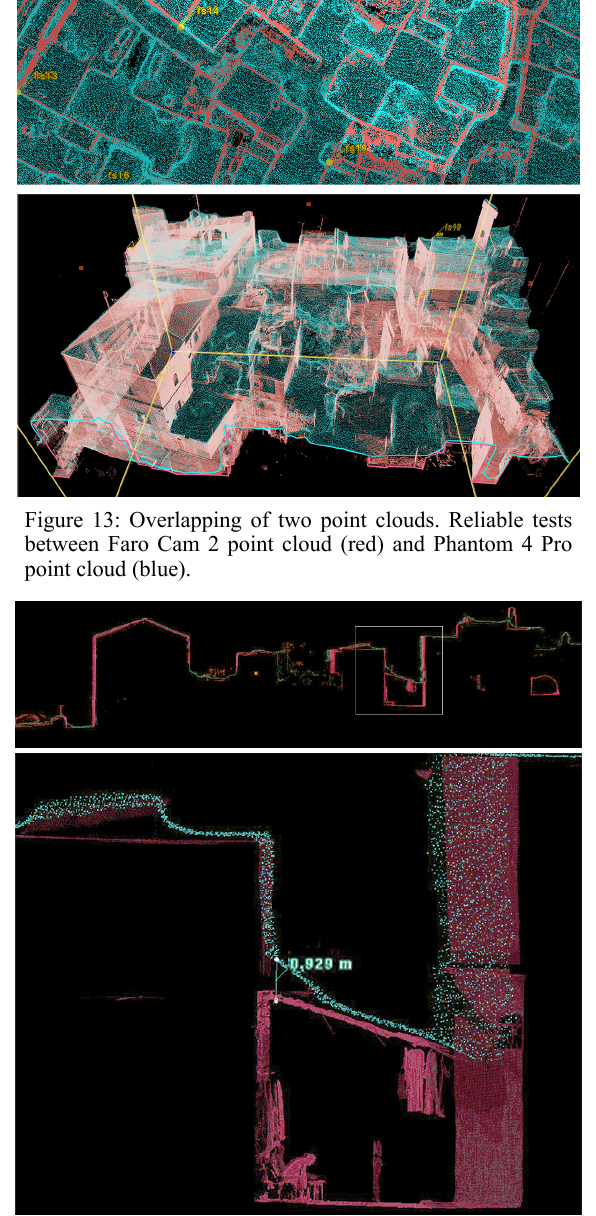
Figure 14: The reliable test on elevations and on environmental sections. The laser scanner point cloud (red) and the Phantom 4 Pro point cloud